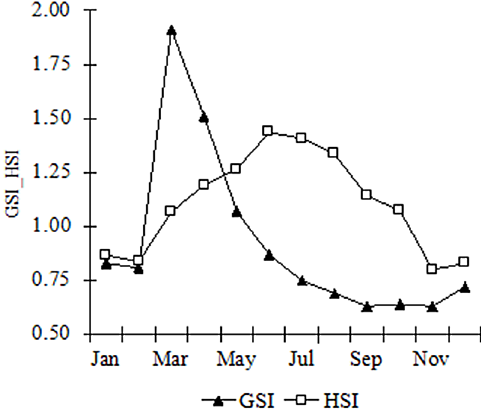
Fig. 9. Mean monthly gonadosomatic (GSI) and hepatosomatic (HSI) indices averaged across 2010 – 2016 (sexes combined) for T. picturatus from north-east Atlantic waters (Portuguese